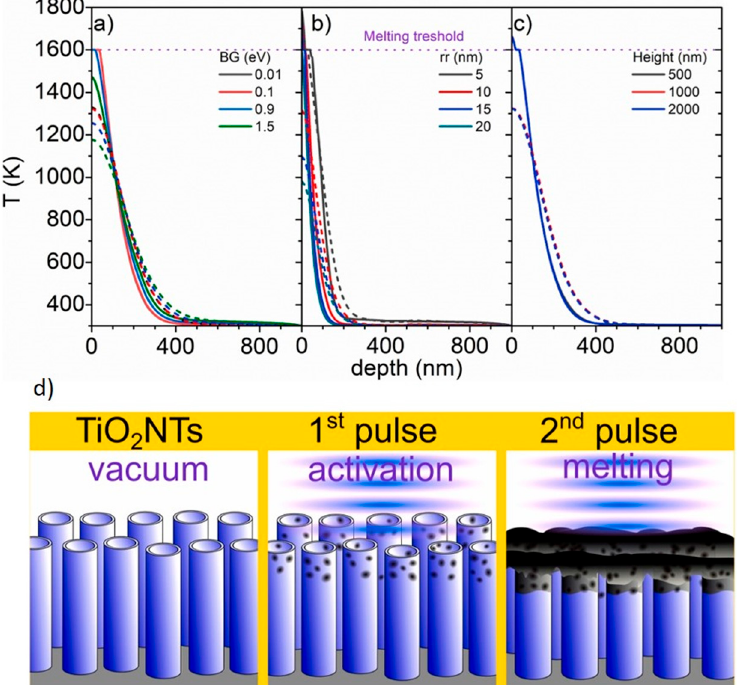
Figure 2. Temperature distribution in laser-treated TiO 2 nanotubes as a function of ( a ) optical bandgap (BG), ( b ) initial wall thickness, and ( c ) height. ( d ) Evolution of titania material morphology during laser annealing. Reprinted with permission from [46].